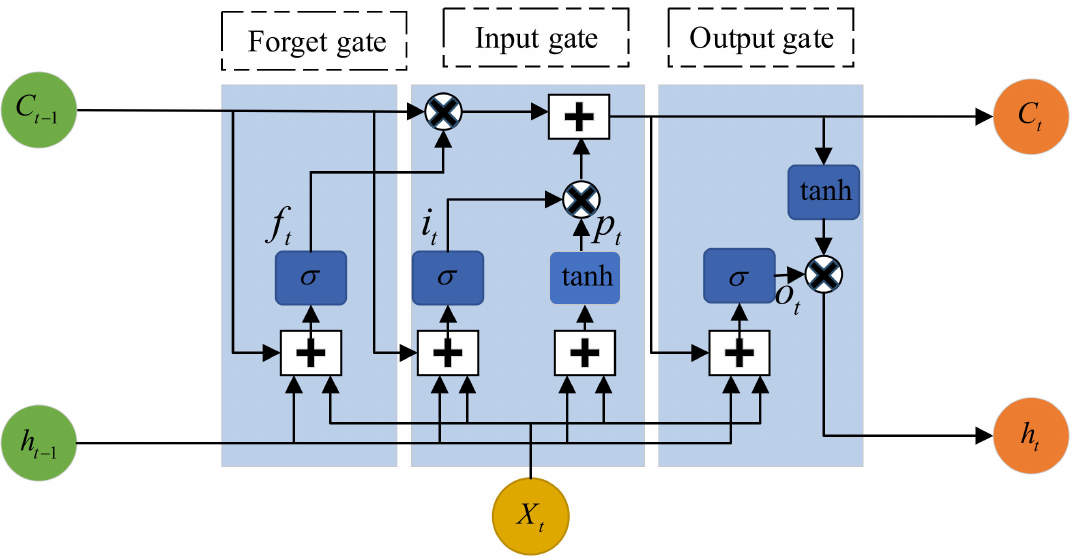
Figure 12. The specific mechanism used by the LSTM